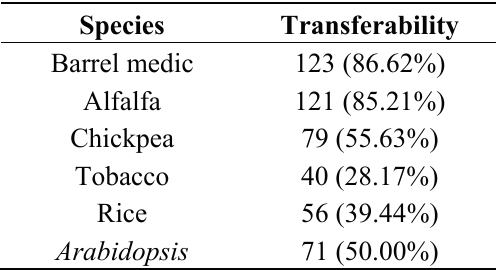
Table 2. Transferability of M. truncatula TFGM markers in leguminous and non-leguminous